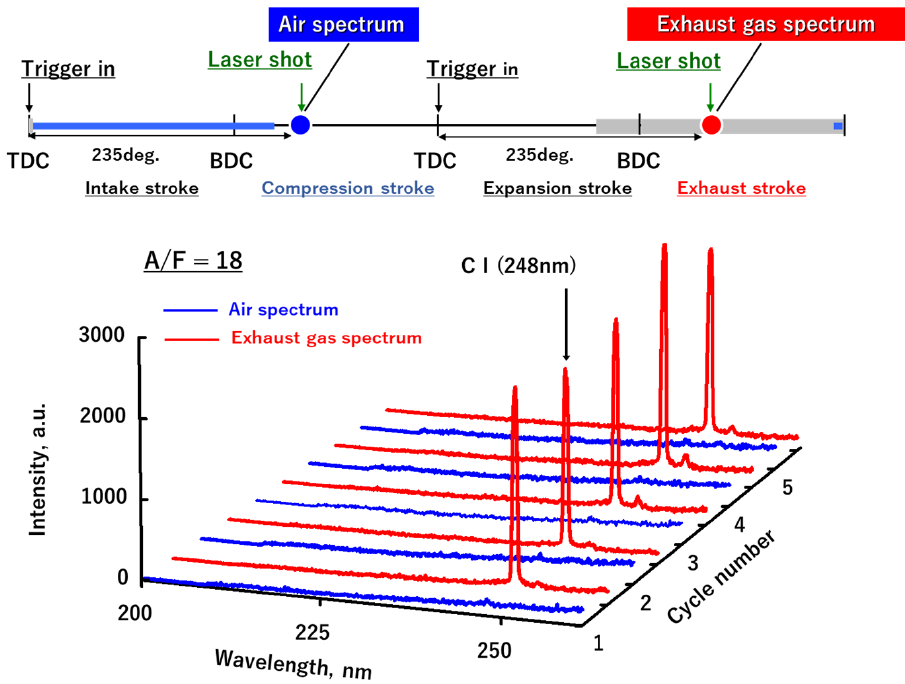
Figure 7. LIBS spectrum for each laser shot (200~270 nm wavelength range). The cyclic variation of the atomic CI is observed for the compression and exhaust strokes.